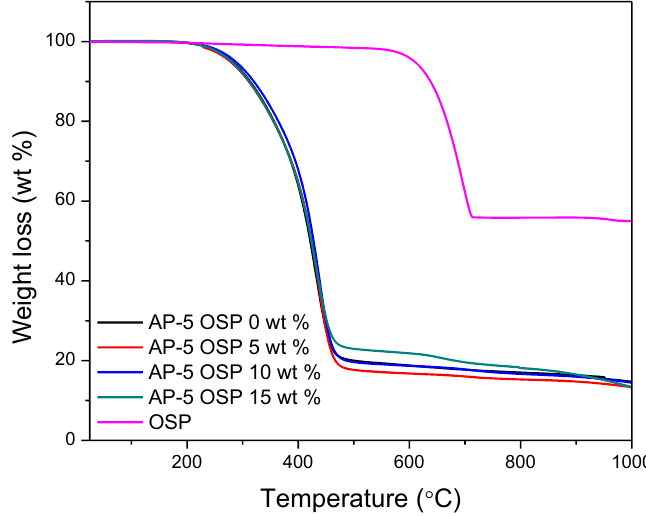
Figure 13. TGA thermograms of OSP, neat asphalt, and OSP-filled asphalts.